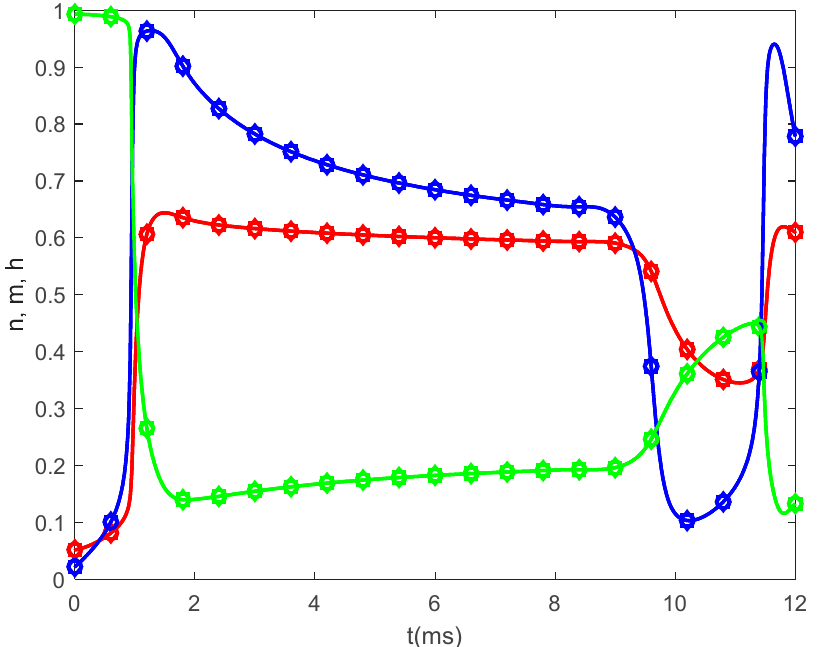
Figure 7. Time variations of the gating variables n ( t ) (red), m ( t ) ( blue), and h ( t ) (green), obtained by solving the fractional Hodgkin–Huxley Equations (35)–(38) for β = 0.7. Here, α = 0.65 and p = 0.75, q = 0.25 (square symbol); p = q = 0.5 (diamond symbol); and p = 0.25, q = 0.75 (circle symbol).